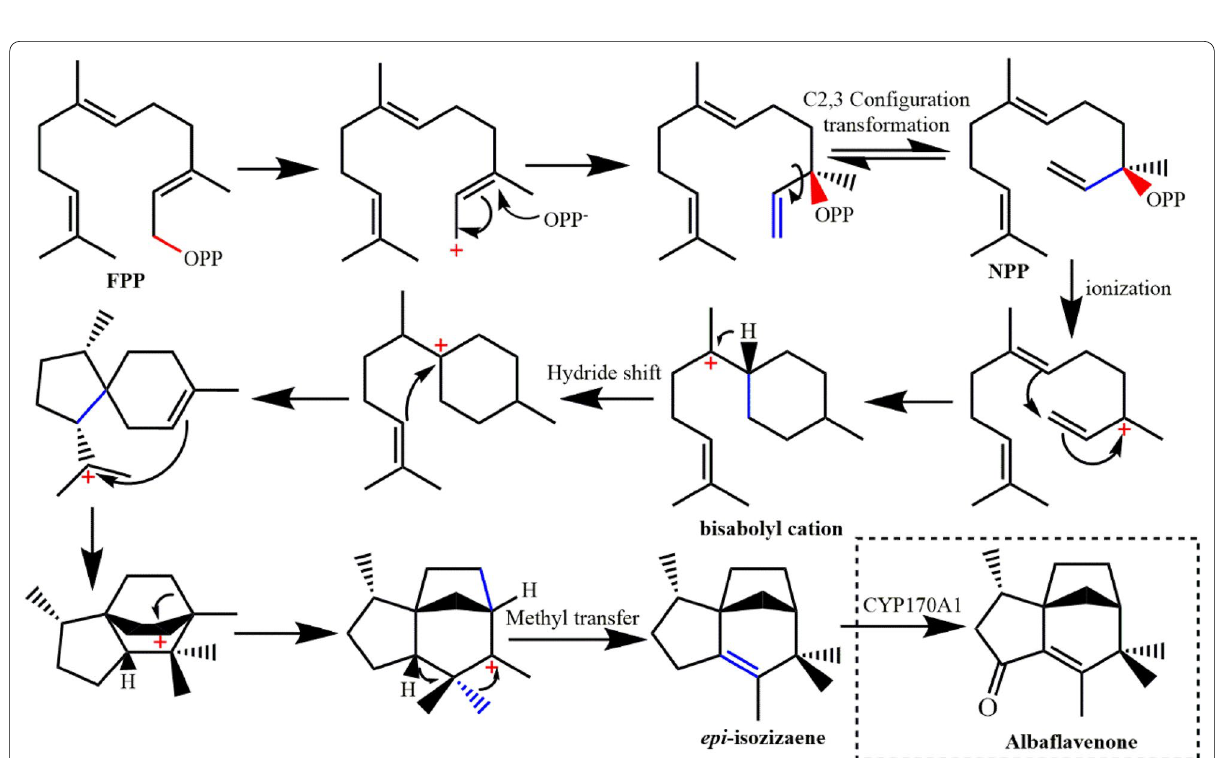
Fig. 10 Cyclization reaction catalyzed by EIZS. Dashed box shows the formation of albaflavenone